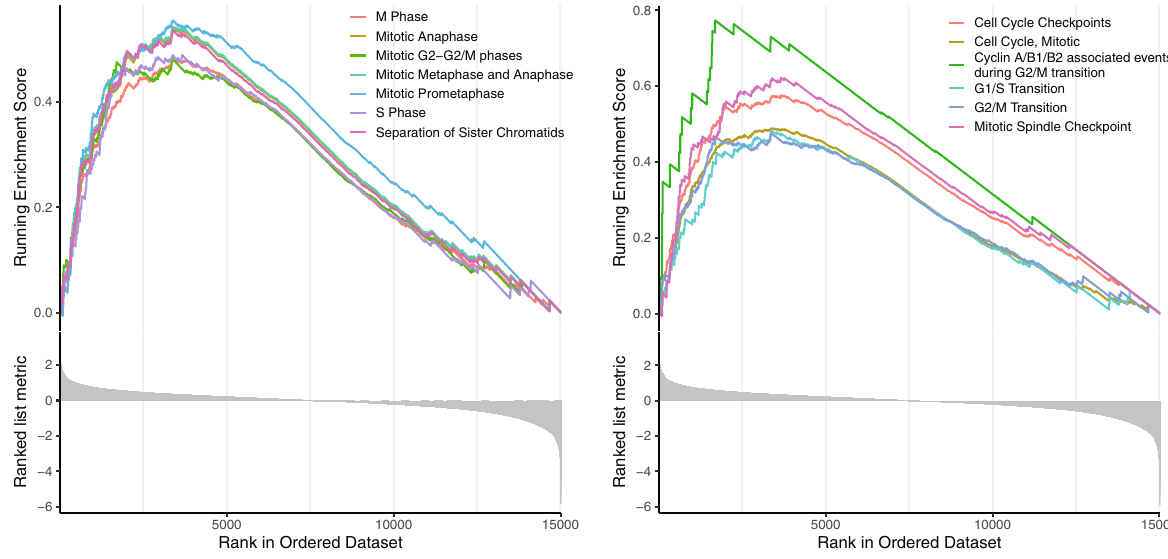
Fig. 5 Representative gene set enrichment analysis plot showing upregulation of cell cycle-related genes. On x -axis, genes are ranked based on log 2 fold change of gene expression level. From top to bottom, they are enrichment score of pathways on each gene, log 2 fold change of expression